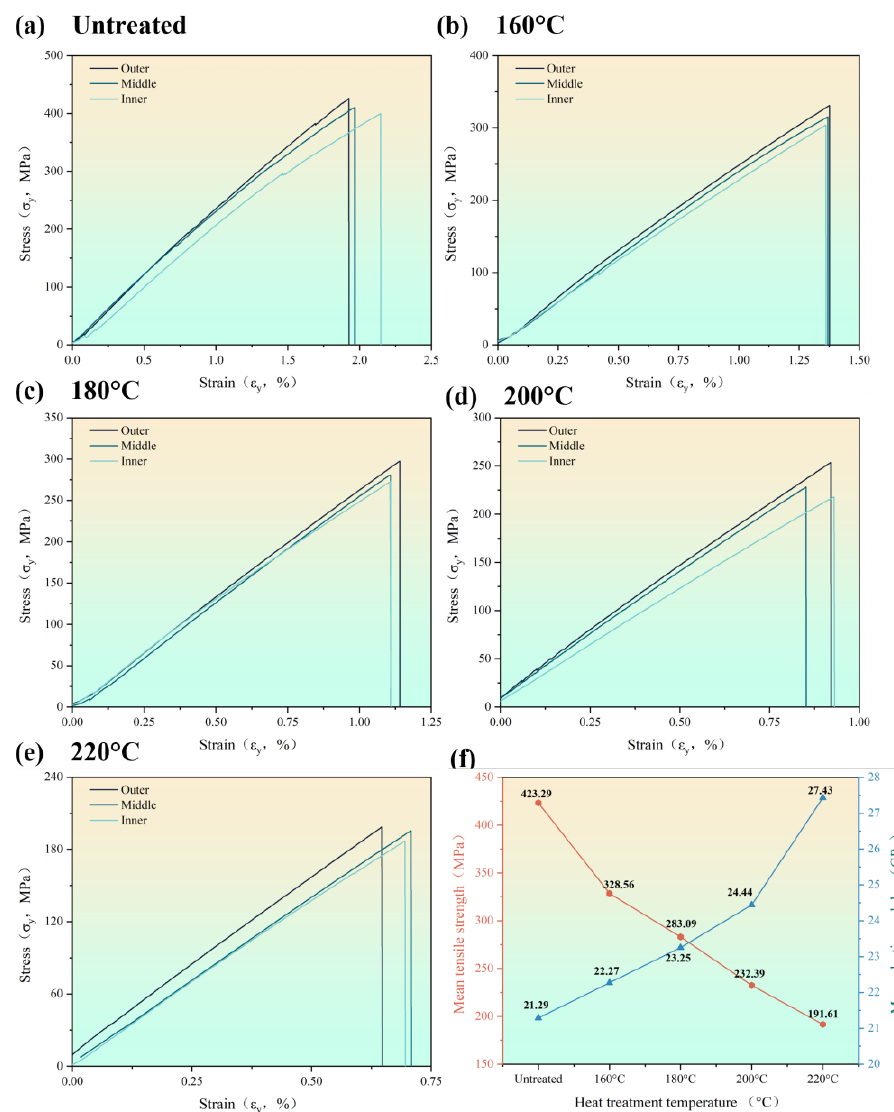
Figure 3. Tensile behavior of the untreated specimen: ( a ) the stress–strain curve of the untreated specimen; ( b ) the stress–strain curve of the specimen at 160 ◦ C; ( c ) the stress–strain curve of the specimen at 180 ◦ C; ( d ) the stress–strain curve of the specimen at 200 ◦ C; ( e ) the stress–strain curve of the specimen at 220 ◦ C; ( f ) the mean tensile strength and elastic modulus of bamboo